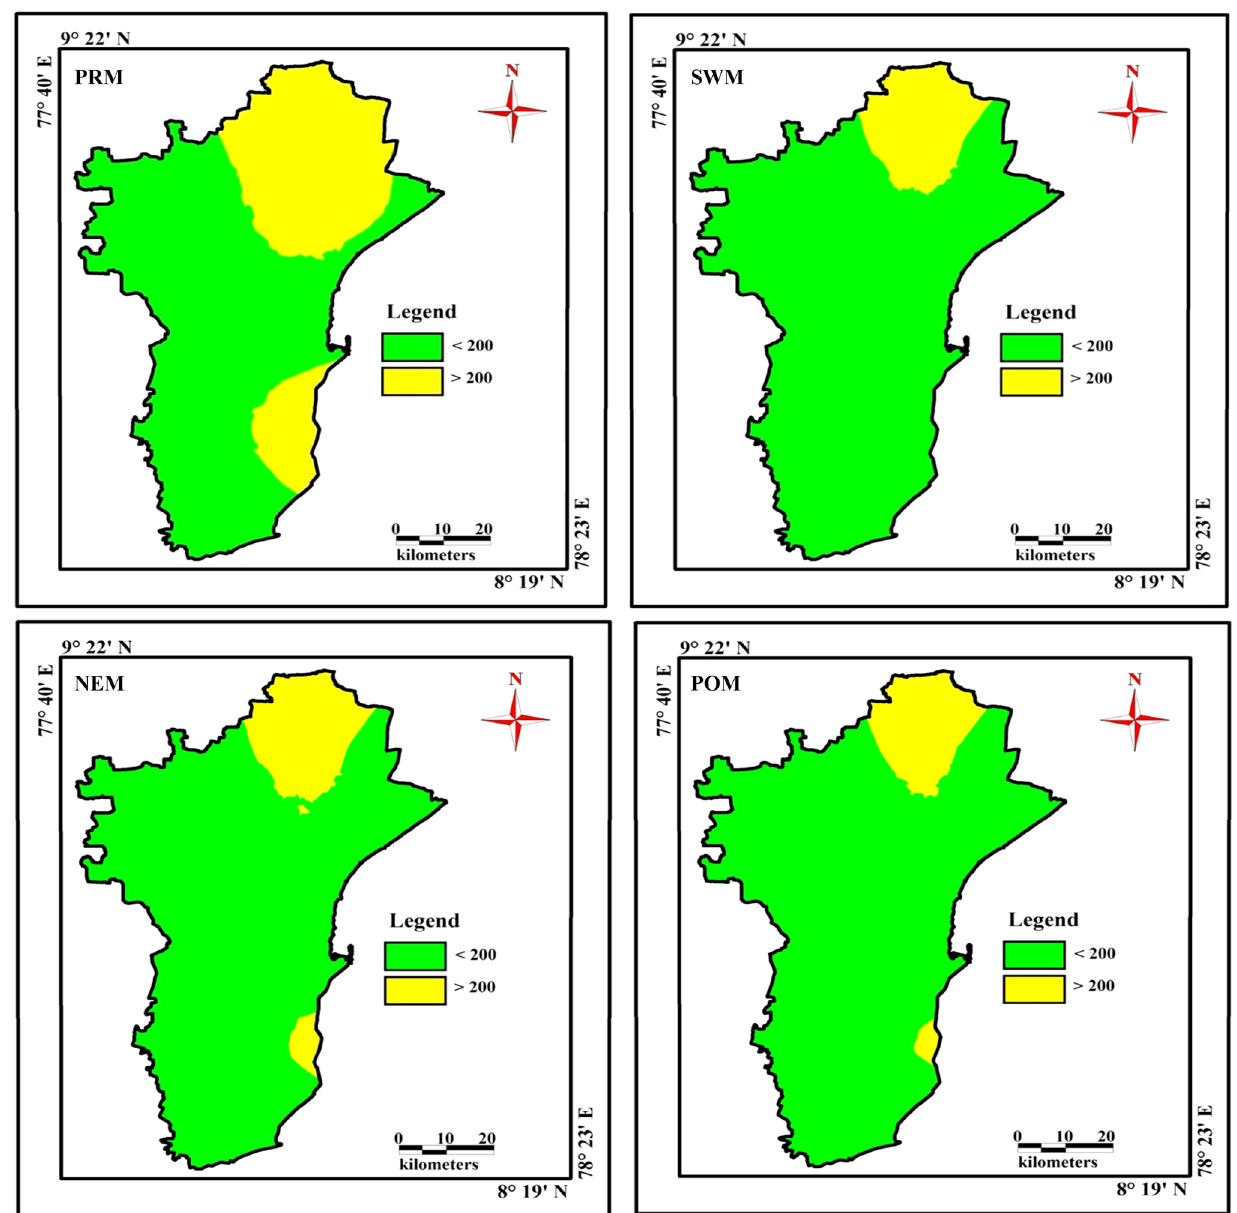
Fig. 11 Spatial distribution of HCO − 3 during different